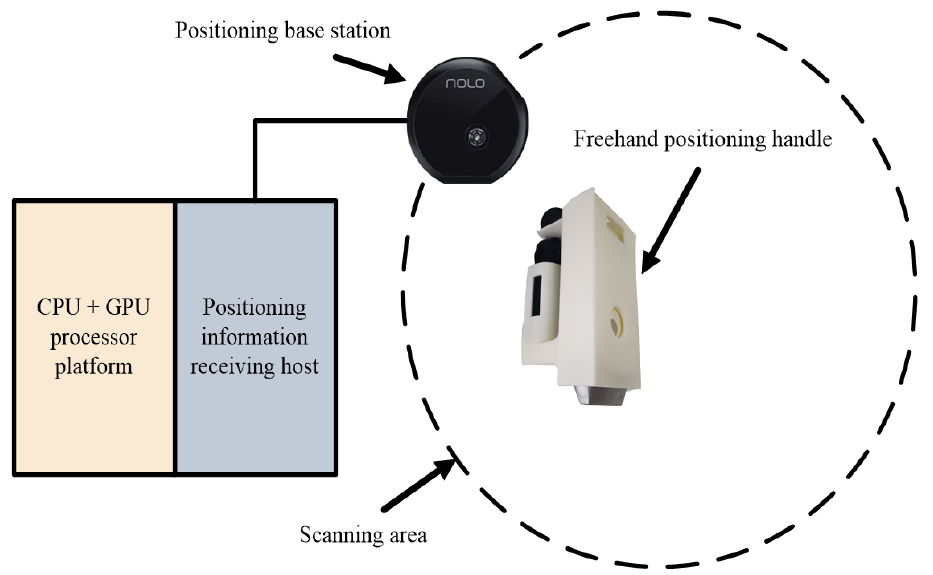
Figure 8. The hardware of SPRAO system.